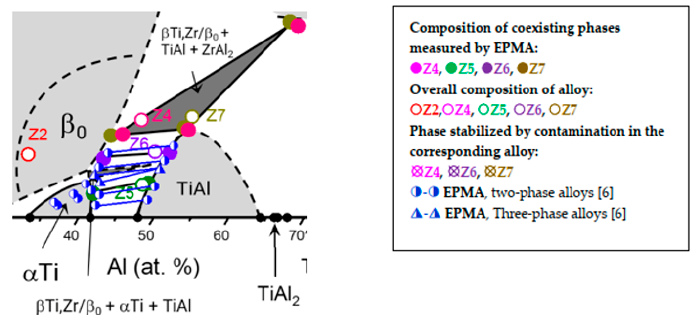
Figure 8. Enlarged section of the Ti—Al—Zr partial isothermal section at 1200 °C (Figure 7) with added EPMA data by [6]. Partial isothermal sections for compositions Ti-(30 – 60)Al-30Zr at. % Zr were calcu- lated at 1200 °C in [21,22]. Although both modellings are based on data in [6], comparison of experimental data and modelling in [21,22] show an unsatisfactory match. Both mod- ellings differ from phase equilibria shown in Figure 7, in that they show β Ti,Zr in